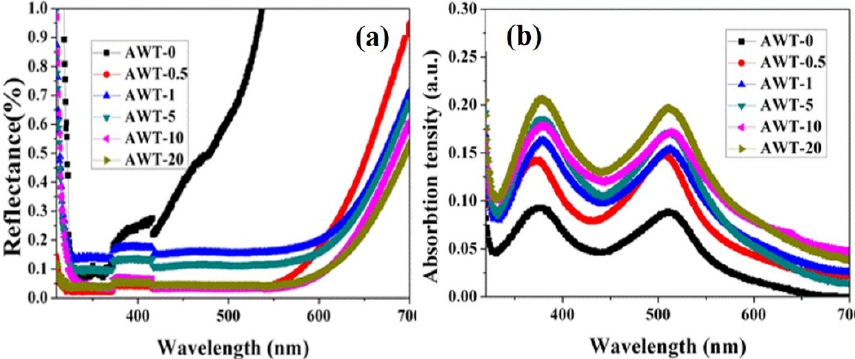
Figure 6. ( a ) Reflectance spectra for the composite electrode films after N719 desorption attached and ( b ) absorption spectra for the composite electrode films after the dye uptaking process.